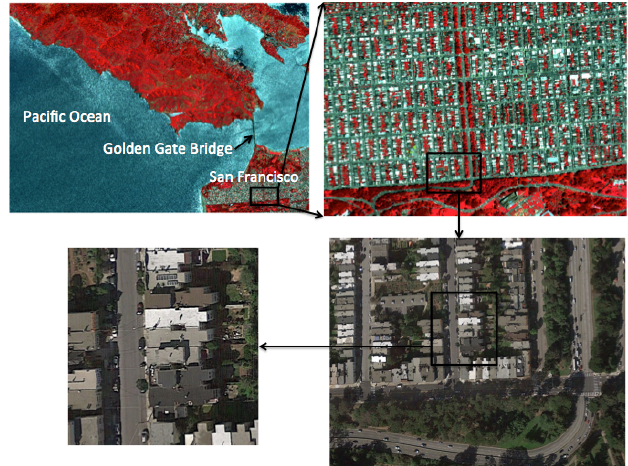
Figure 2. Study area: FCC of a part of San Francisco city. Zoomed image of the urban area (marked with rectangle in inset) shows mixing of substrate with vegetation, roads, shadows and dark